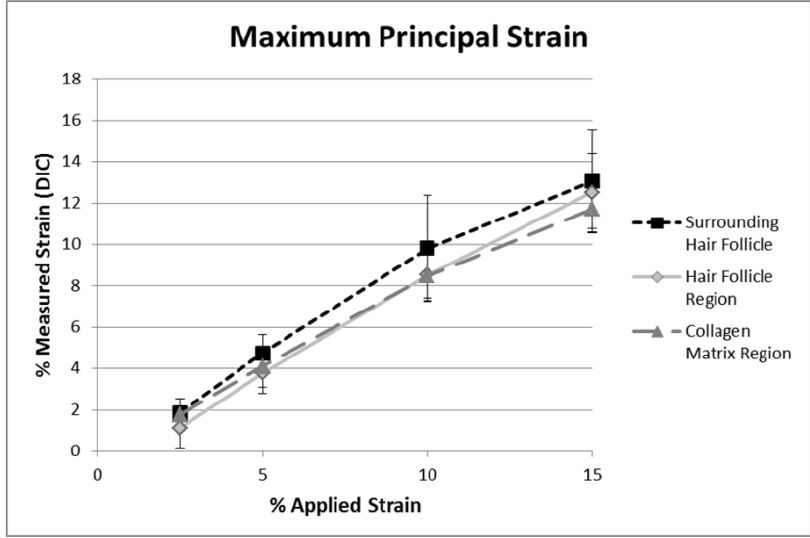
Figure 6. Maximum principal strains averaged over the three regions indicated 4, versus applied strain. All three regions of collagen ( i.e. , hair follicle, surrounding hair follicle, and matrix) increase with applied strain ( p < 0.001). There is no statistical significance between locations. Error bars represent ±1 Standard